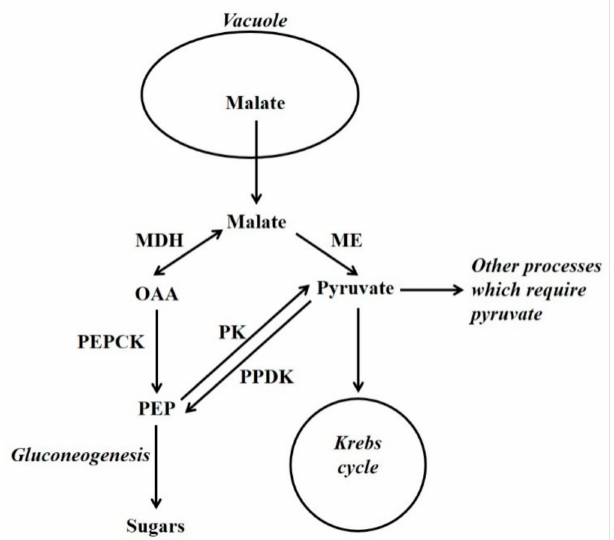
Figure 2. The utilisation of vacuolar-released malate by gluconeogenesis and other processes such as the Krebs cycle. OAA = oxaloacetate; PEP = phosphoenolpyruvate; MDH = malate dehydroge- nase; ME = malic enzyme; PEPCK = phosphoenolpyruvate carboxykinase; PK = pyruvate kinase; PPDK = pyruvate orthophosphate